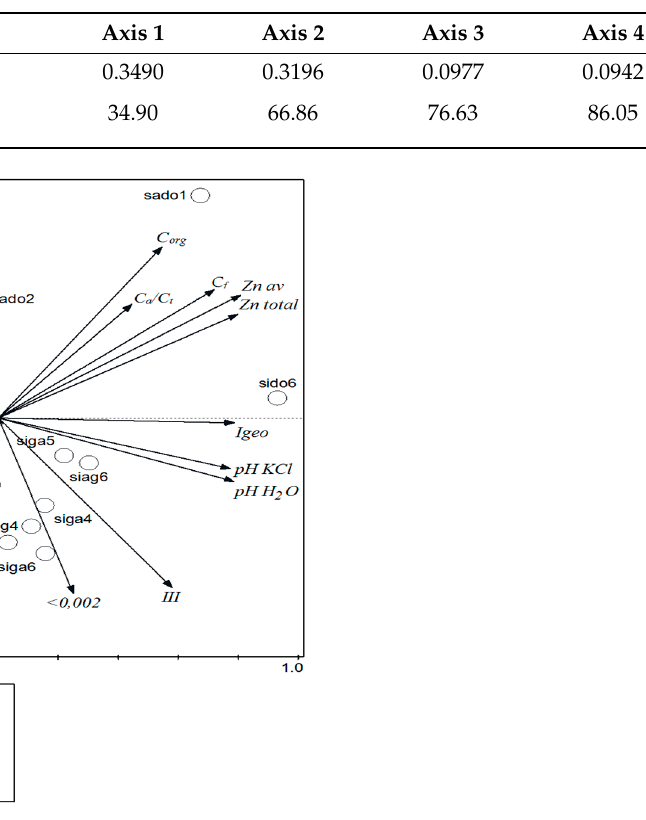
Figure 4. Principal component analysis (PCA) of two indices for the zinc content and parameters. Table 4. Summary of the Zn results in